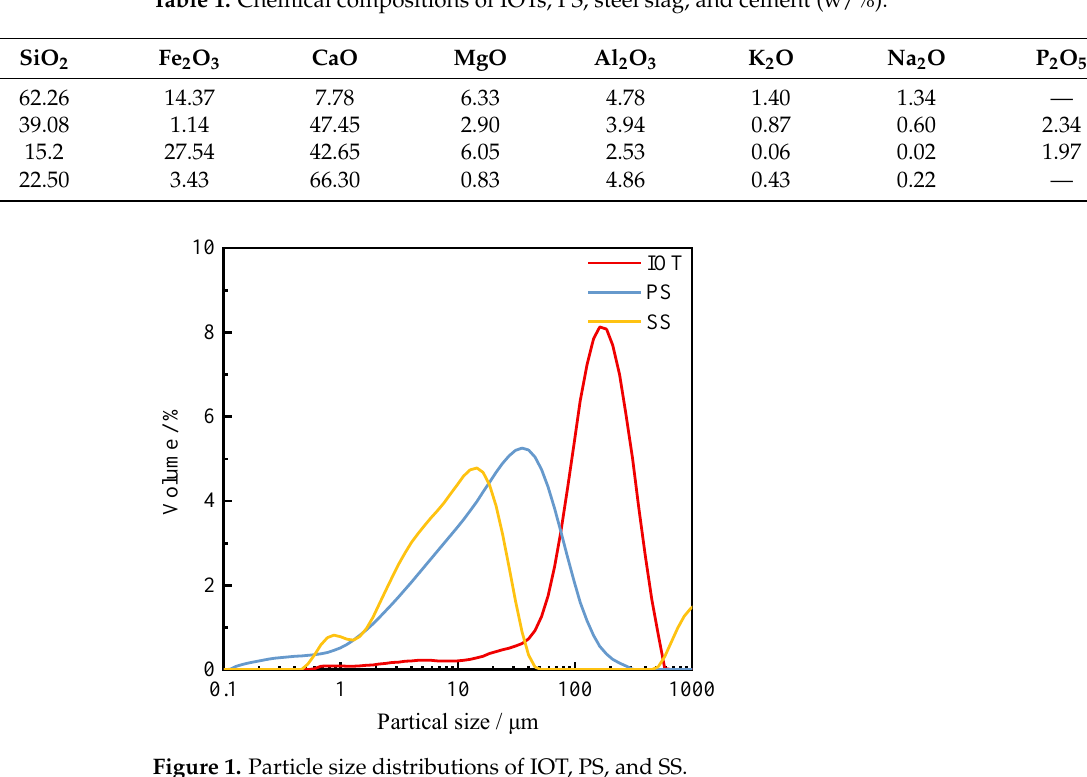
Figure 1. Particle size distributions of IOT, PS, and SS.